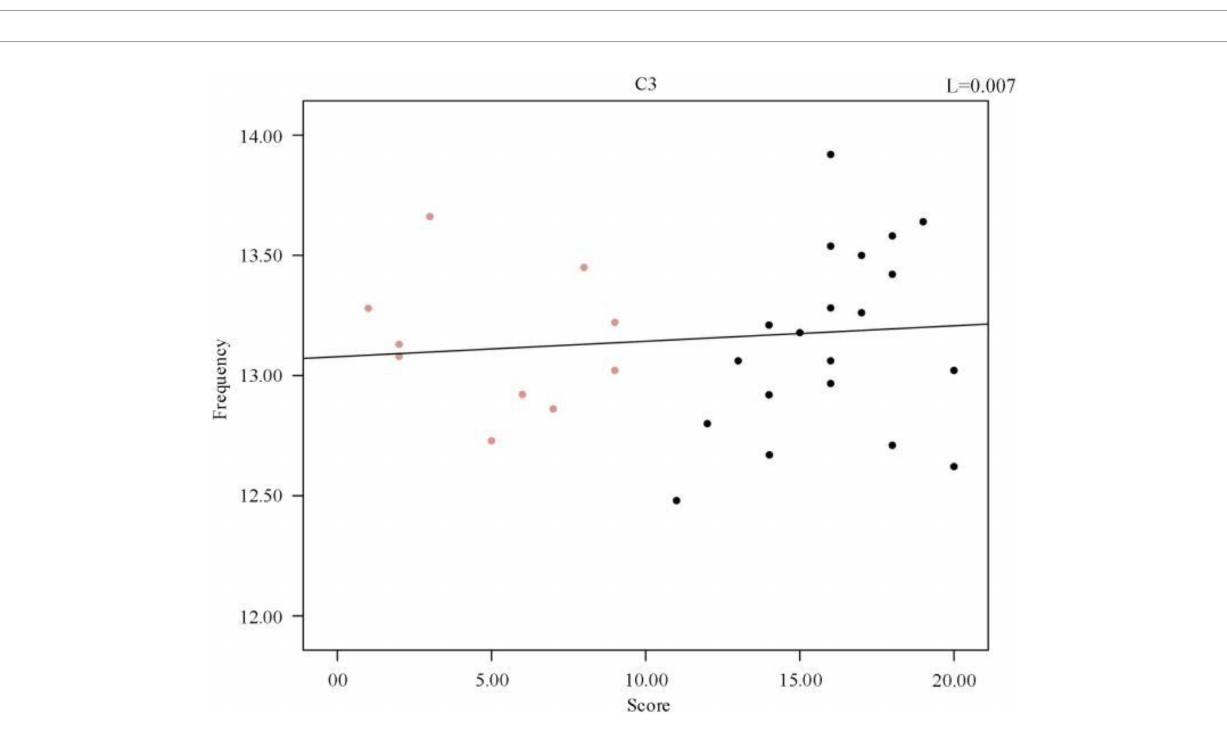
FIGURE6 Overall spindle frequency distribution of sleep-disordered and normal subjects.